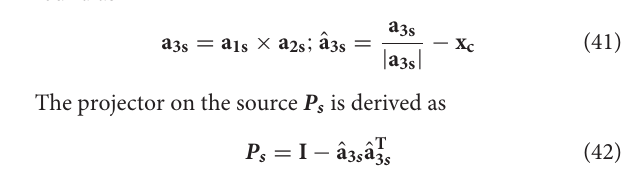
FIGURE 8 | Top row : a regular black cube is deformed onto the red parallelepiped. Bottom row : F is then projected onto single faces using the procedure exposed in the text. Six projected tensors are then obtained. projection of F on the plane containing the face. To